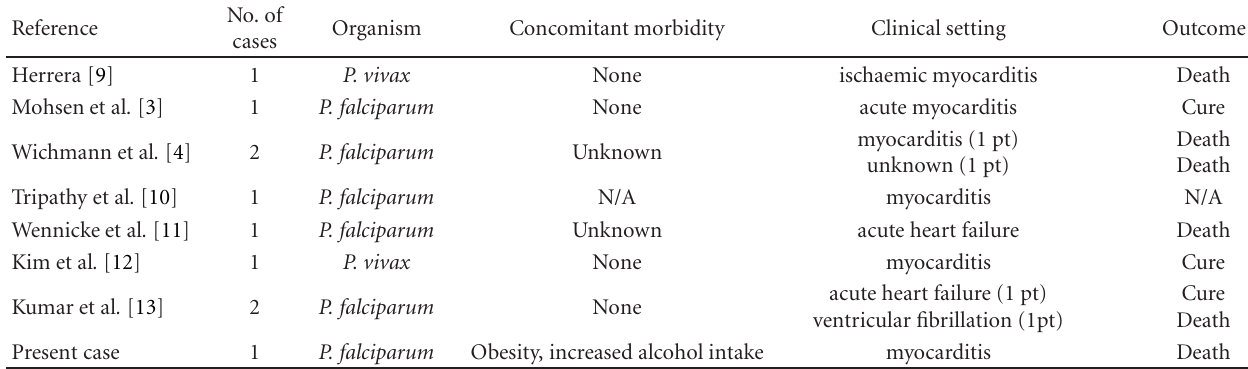
Table 2: Cases of cardiac complications in severe malaria (reported as of January